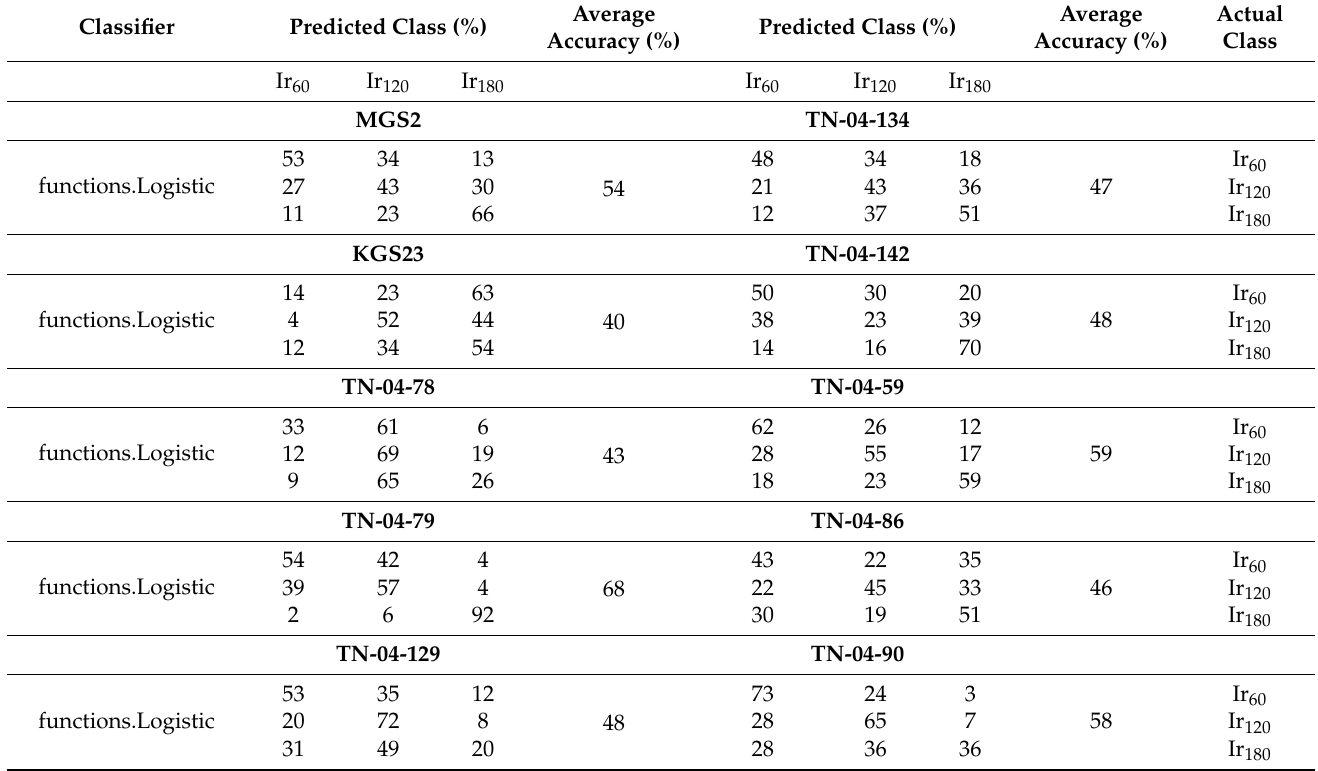
Table 2. The confusion matrices and accuracies of discrimination of sorghum grain subjected to normal irrigation, mild deficit irrigation, and severe deficit irrigation based on a set of selected geometric